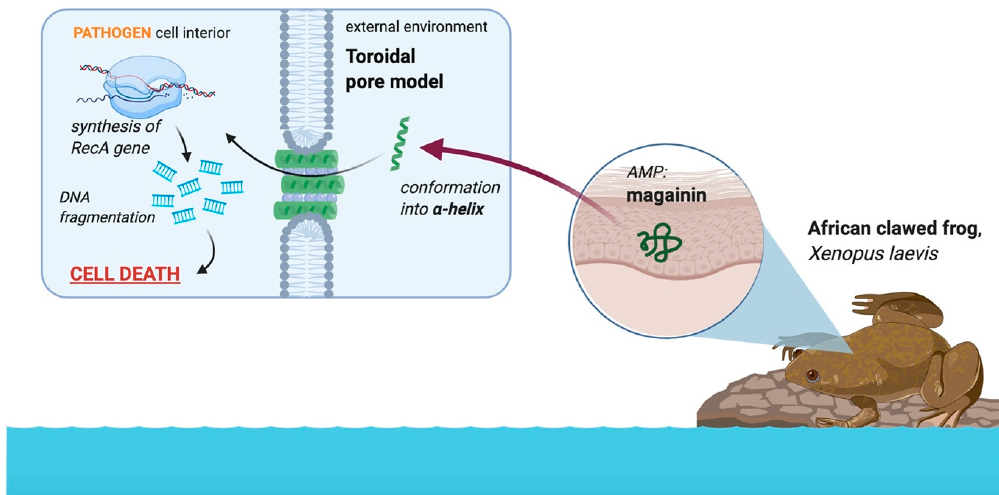
Figure 5. Role of the AMP magainin in the African clawed frog in the defense against amphibian pathogens. The peptide is located in the dermis of the African clawed frog skin and conforms into an alpha helix upon interacting with a negatively charged membrane, resulting in the formation of toroidal pores in most instances. The peptide interferes with internal metabolic processes by activating the RecA gene, which causes DNA fragmentation [41]. This ultimately kills the pathogen. Image created with BioRender.com.